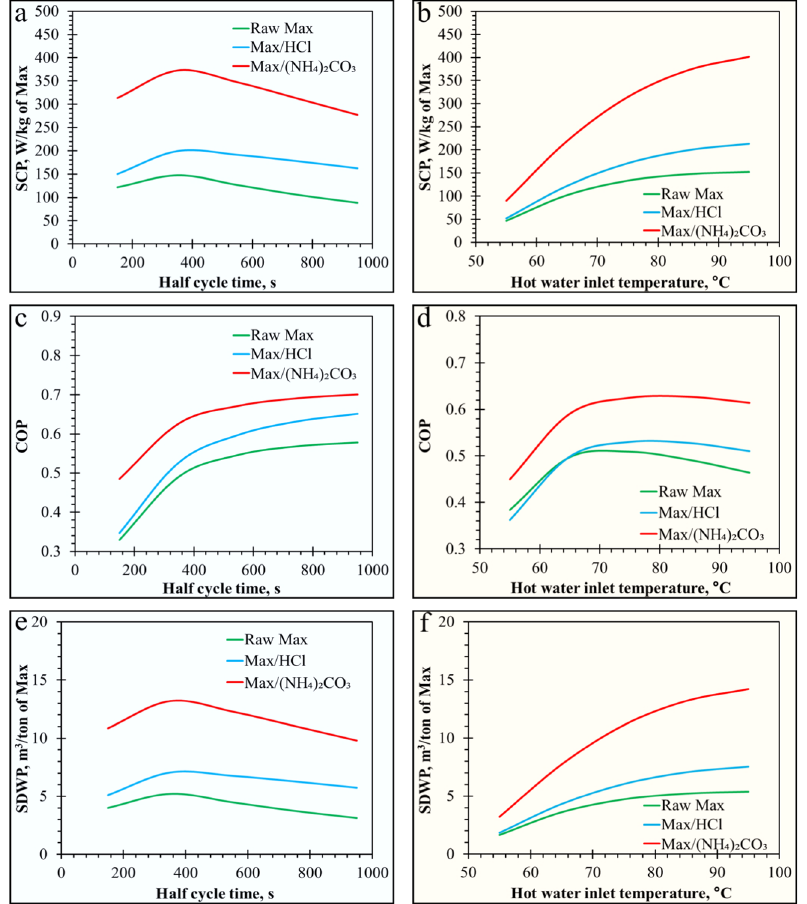
Fig. 5 ACD cycle performance. a SCP with a different half t cycle , b SCP with a different De-T, c COP with a different half t cycle , d COP with a different De-T, e SDWP with a different half t cycle , and f SDWP with a different De-T. The optimum SCP and SDWP of raw and modi fi ed Max were recorded at 350 s half t cycle . Both SCP and SDWP rise as the De-T